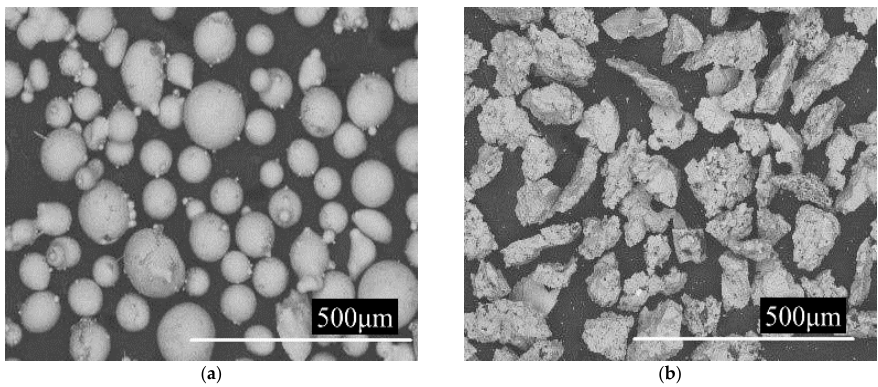
Figure 1. ( a ) Morphology of Ni35A powder. ( b ) Morphology of TiC powder.